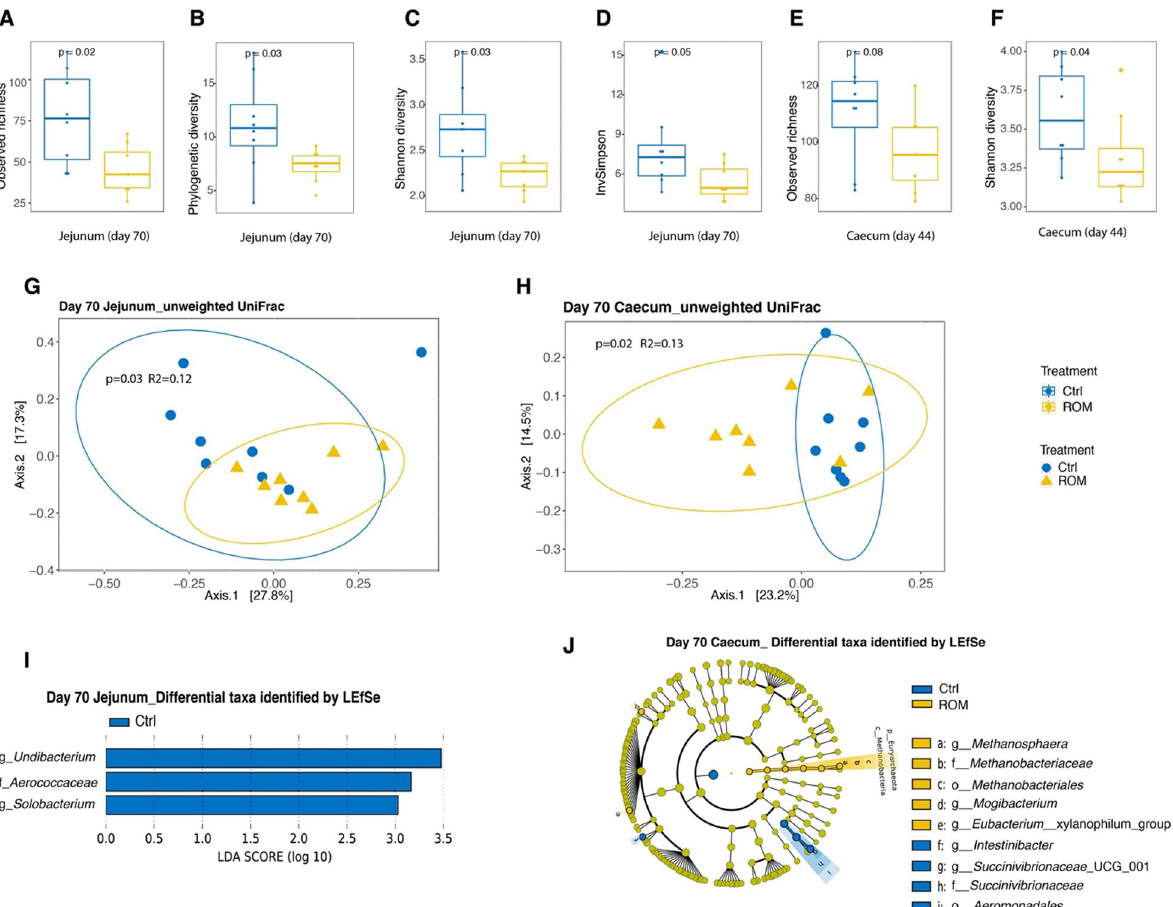
Fig. 4 The effect of ROM treatment on luminal microbiota colonization. Boxplots show comparisons of jejunal luminal microbial alpha diversity between ROM and Ctrl groups on day 70 based on observed richness ( A ), phylogenetic diversity ( B ), Shannon diversity ( C ) and inverse Simpson (InvSimpson) ( D ), as well as caecal luminal microbial diversity between two groups on day 44 with indices of observed richness ( E ) and Shannon diversity ( F ). Differences in alpha diversity between groups were evaluated by nonparametric Wilcoxon rank sum test. Principal coordinate analysis (PCoA) plots for jejunal luminal microbiota ( G ) and caecal luminal microbiota ( H ) at ASV level both on day 70 based on unweighted UniFrac. Significance of the difference between ROM and Ctrl groups was assessed using PERMANOVA. The percentages at the axes indicate the variation explained. Linear discriminant analysis (LDA) Effect size (LEfSe) of differentially abundant jejunal taxa between ROM and Ctrl groups on day 70 ( I ). Cladogram of caecal differentially abundant taxa between ROM and Ctrl pigs on day 70 according to LEfSe ( J ). Blue and yellow colours represent control (Ctrl) and treated (ROM) groups,